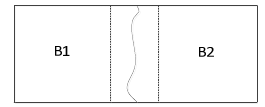
Figure 3. Minimum error boundary